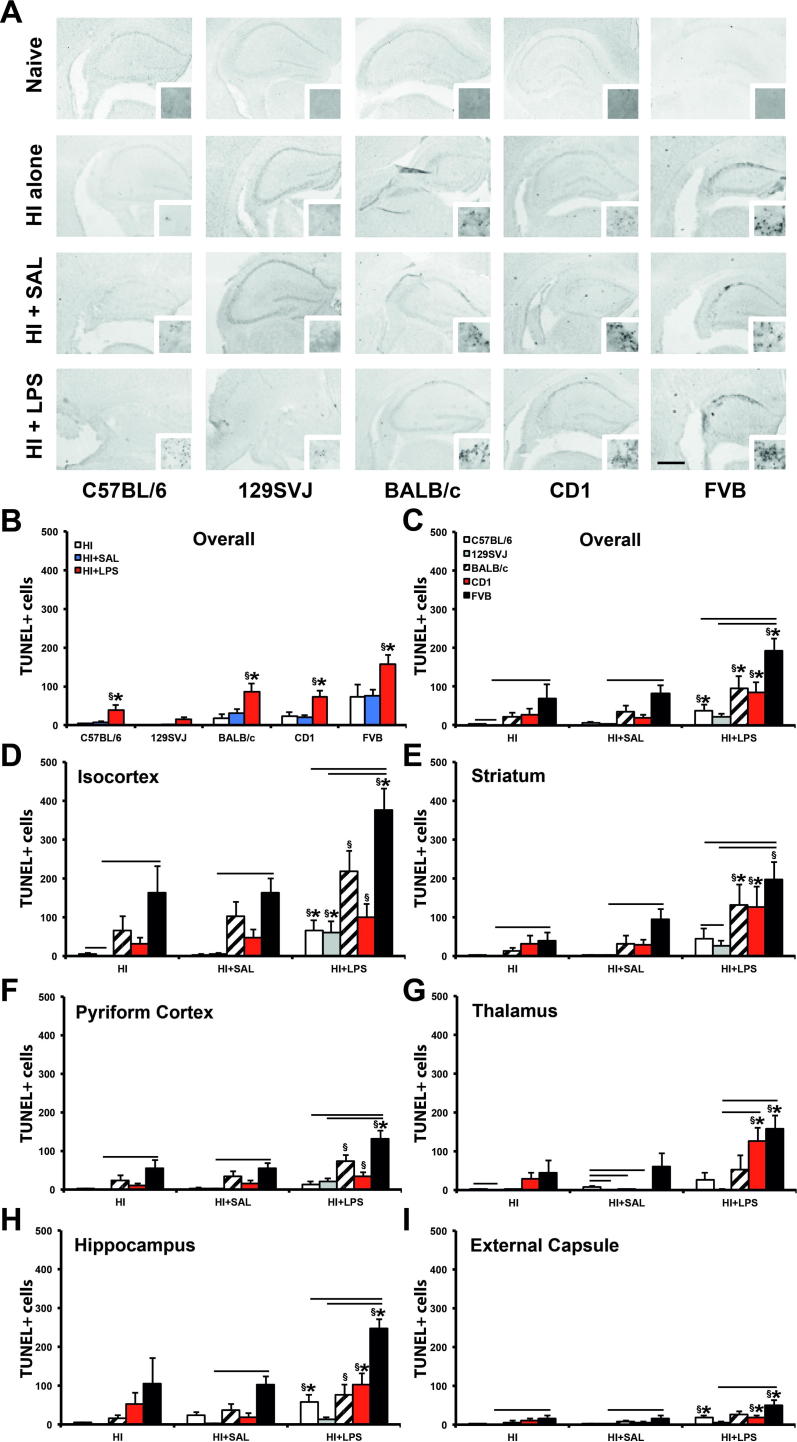
DNA fragmentation-associated cell death detected with TUNEL is increased in animals pre-treated with LPS across all assessed mouse strains. (A) TUNEL assay of 40-μm coronal hippocampal sections of C57BL/6, 129SVJ, BALB/c, CD1 and FVB strains 48 h following hypoxia–ischemia. The upper row shows untreated naïve animals, second row mice exposed to hypoxic–ischemic insult alone (HI alone), third row those injected 12 h earlier with saline (HI + SAL), and lower row animals pre-treated with 0.6 μg LPS/g body weight (HI + LPS). Saline administration prior to hypoxia–ischemia had no significant impact, whereas LPS pre-treatment resulted in substantial increase in TUNEL+ cell death. (B, C) Overall effect across all six brain regions, both in terms of strain (B) and treatment (C) comparison. (D–I) Significantly increased LPS-induced cell death was also present in 5/6 regions in the FVB, 3/6 in the C57BL/6 and CD1, and in 2/6 brain regions of the BALB/c animals, when compared to saline-treated controls. Comparison with HI alone demonstrated an even higher LPS-mediated increase in TUNEL+ cell counts. Despite 129SVJ animals showing no overall significant increase in cell death (A), the isocortex was still significantly affected when comparing HI + LPS vs. HI + SAL and HI + LPS vs. HI alone (D). Interstrain comparison revealed that FVB was the most significantly affected strain, especially in comparison to 129SVJ mice followed by CD1 animals. p < 0.05 for Kruskal–Wallis one-way analysis, followed by Dunn multiple comparison test (∗for HI + LPS vs. HI + SAL, §for HI + LPS vs. HI alone, #for HI + SAL vs. HI alone, overhead bar for interstrain treatment comparison). Bar scale = 0.5 mm.